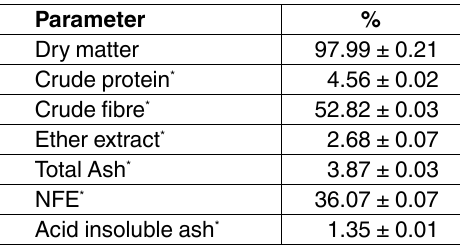
table 2. Chemical composition¹ of Indukantham